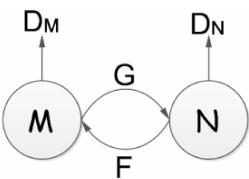
Figure 2. Basic structure of CycleGAN.